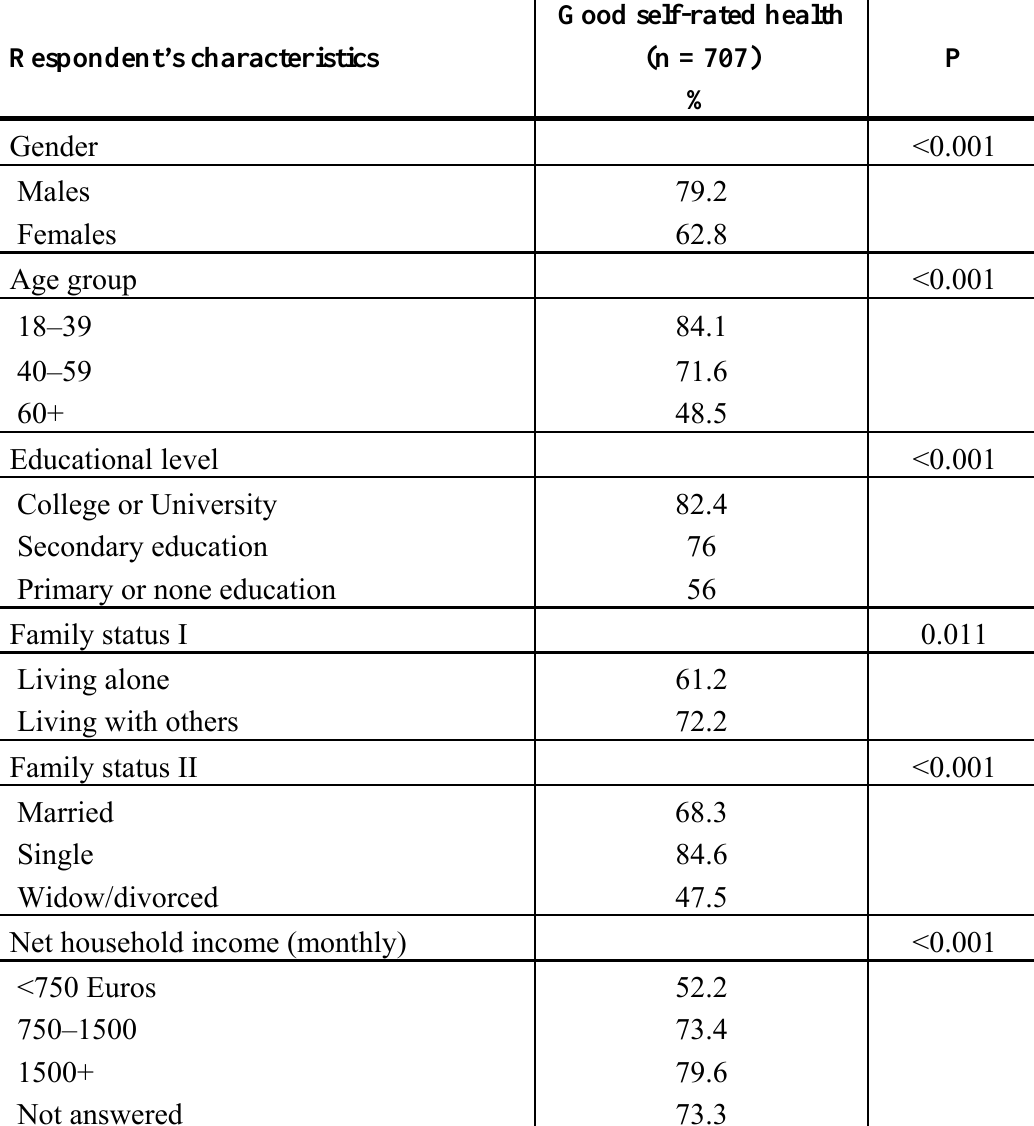
Table 2. Level and equality of perceived health status across different population characteristics (n =